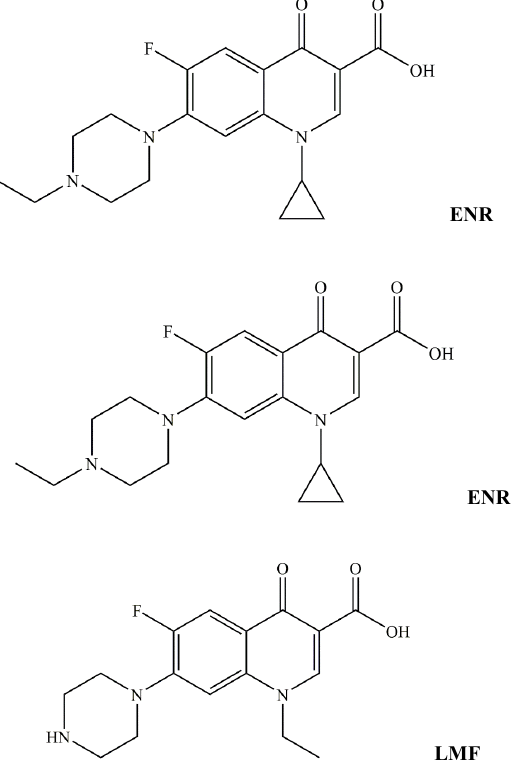
Figure 1: Chemical structure of ENR, LMF and NOR.